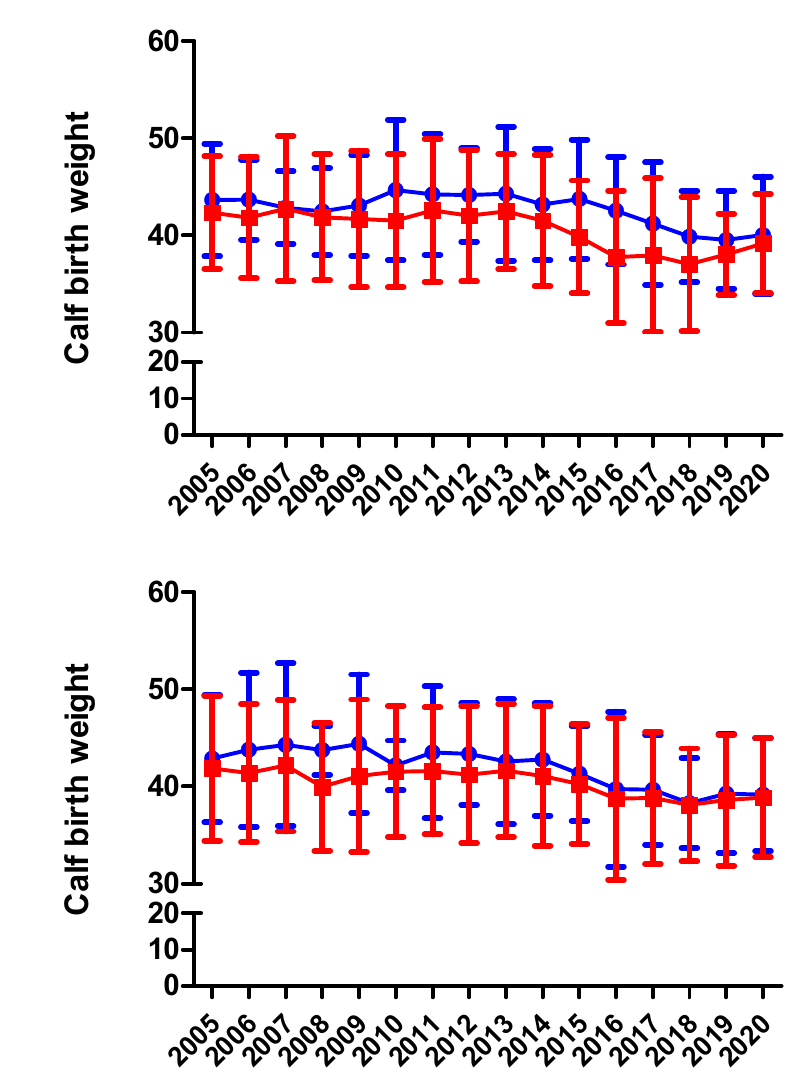
Figure 8. Birth weight of calves from BA ( A ) and BAxL ( B ) split by males (blue filled circles) and females (red filled squares) from 2005 to 2020 in Andorra. Calf birth weights decreased linearly across years for both genders and breed groups ( p < 0.0001); and bull calves were consistently heavier than heifer calves across breed groups ( p < 0.001).